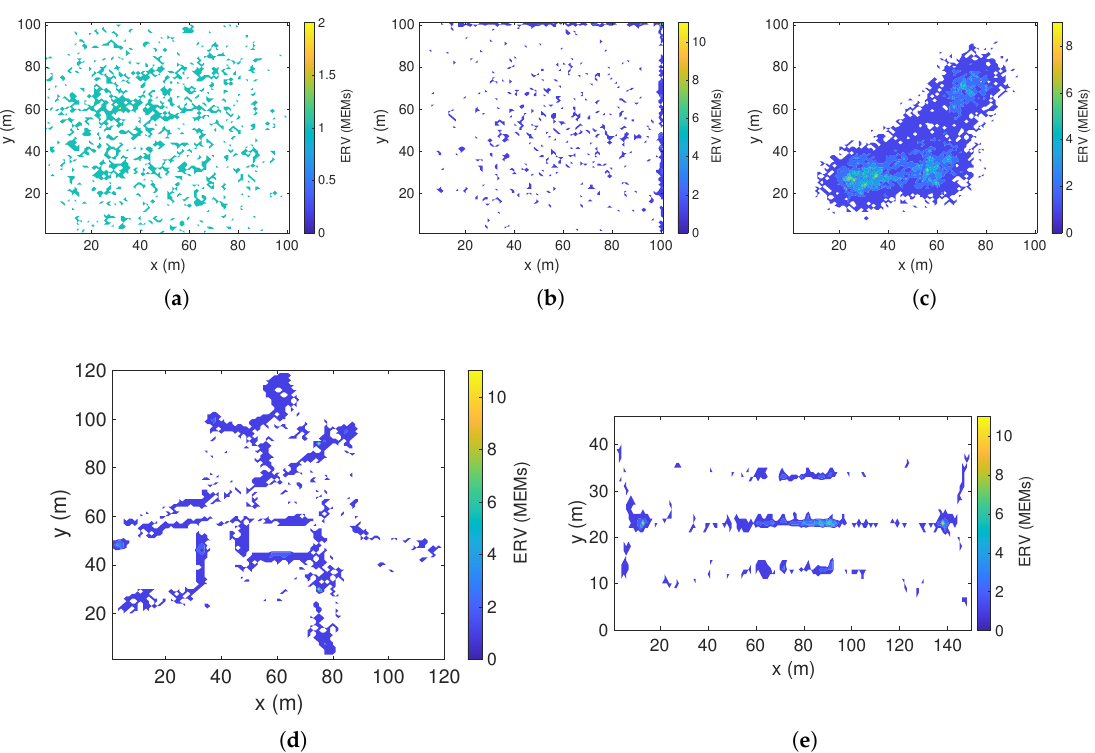
Figure 7. Heat maps of the Exposure Risk Value (ERV) measured in Meaningful Exposure Minutes (MEMs) unit per cell (cell size 1 m 2 ). Higher MEMs value imply higher exposure risk. ( a ) RWP; (b) SWIM: ( c ) RWPa; ( d ) Plaza; ( e ) Station.